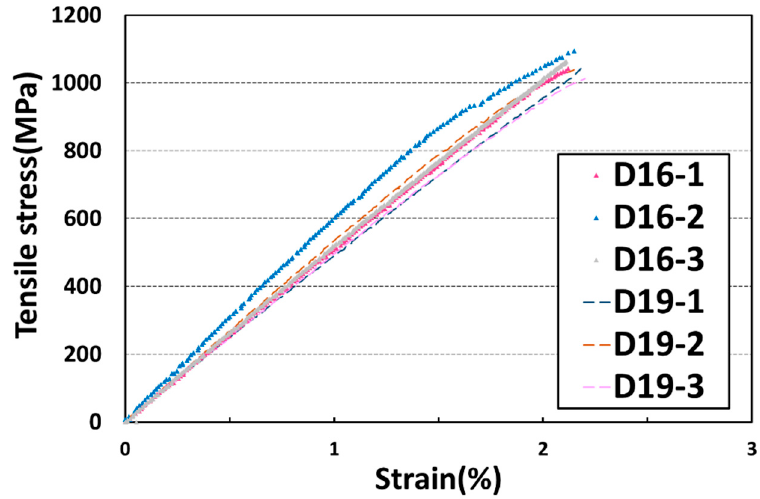
Figure 6. Tensile strength–strain curves of GFRP rebars.